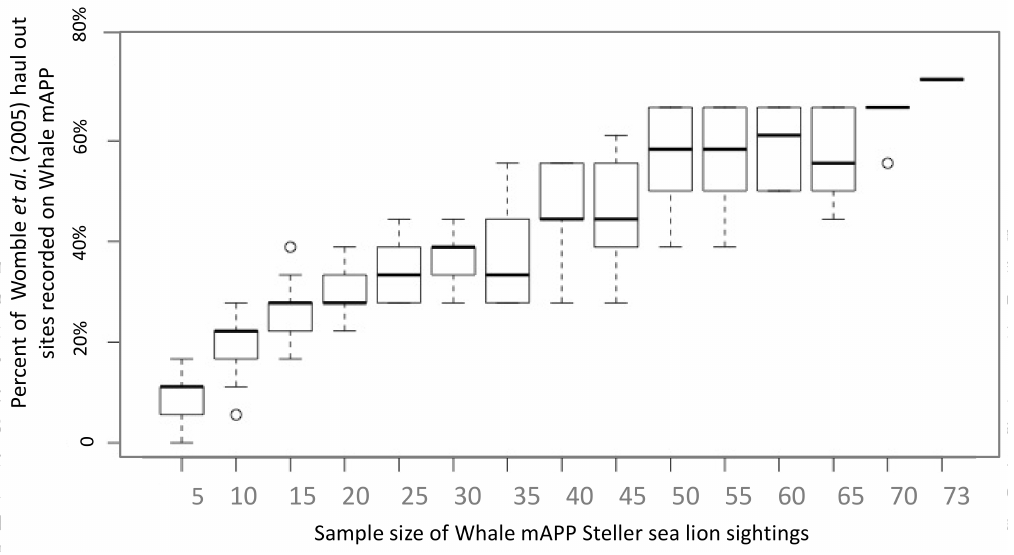
Figure 8. Steller sea lion discovery curve showing an increase in the percent of scientifically collected haul out sites [41] recorded through Whale mAPP with every five-unit increase in Whale mAPP Steller sea lion sighting sample